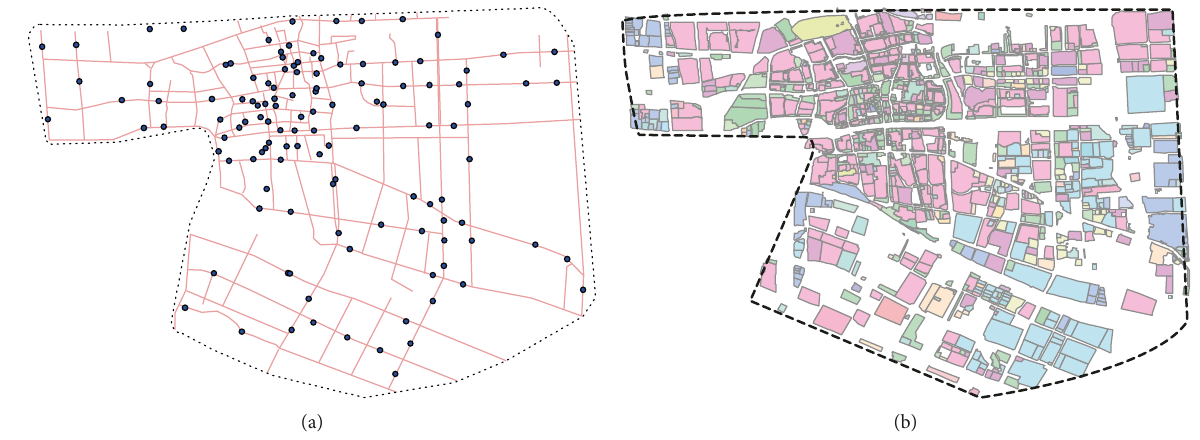
Figure 1: (a) Roadway network and location of microwave detectors and (b) land use sketch of the subject area.